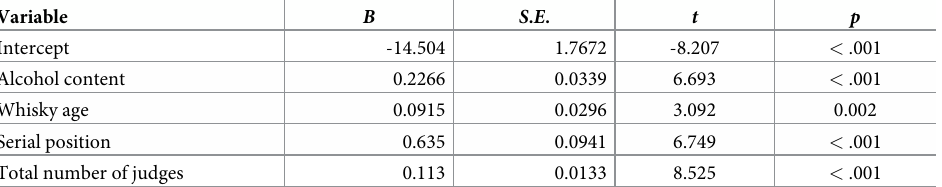
Table 1. Summary of the relative impact of the predictors in the multilevel model with tasting and whisky as lev- els, and the number of people who chose each whisky as their favorite as the outcome variable. Variable